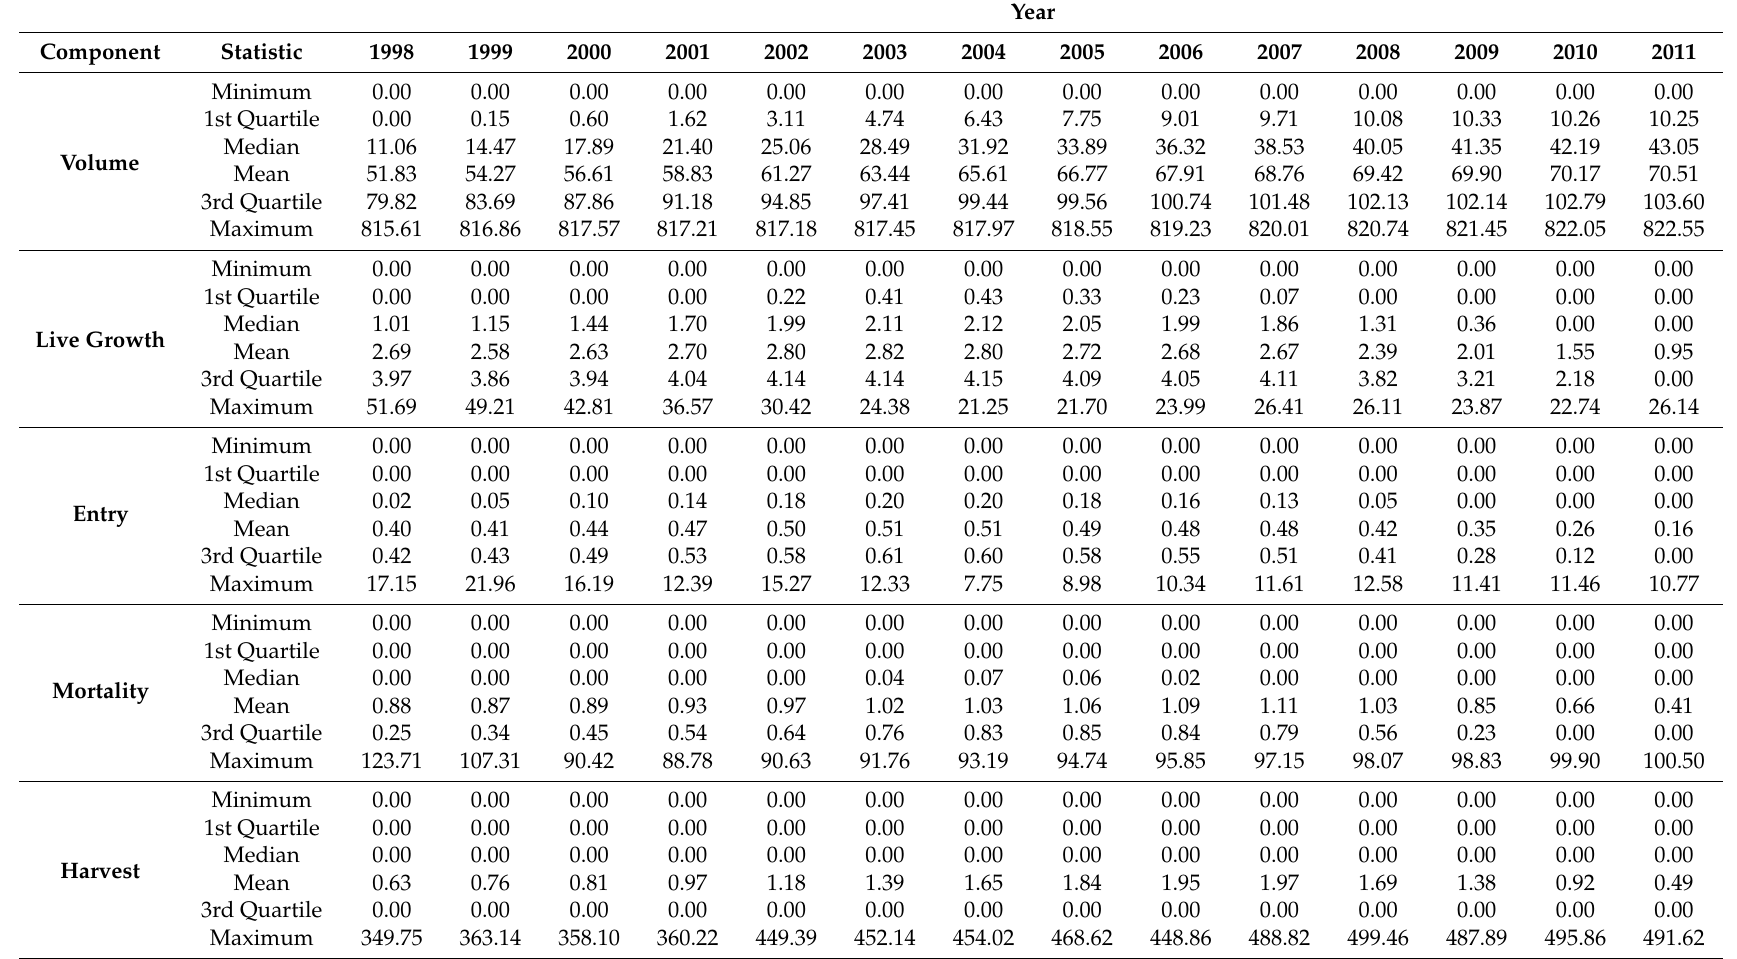
Table A4. Distribution statistics for population